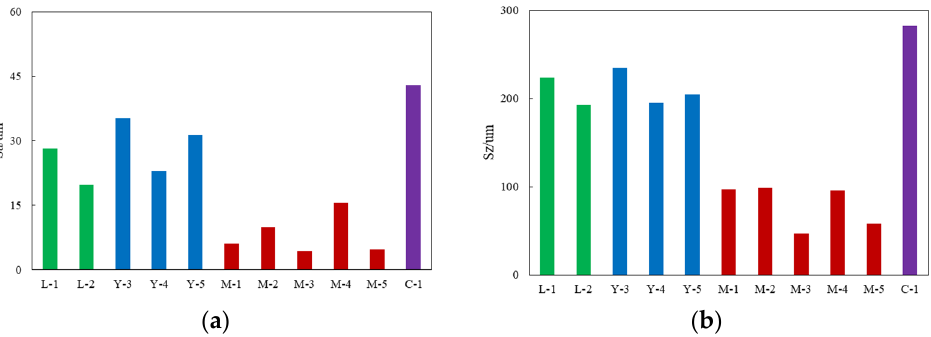
Figure 6. Quantitative characterization parameters of the roughness of partial fracture surface. ( a ) S a of the samples; ( b ) S z of the samples.